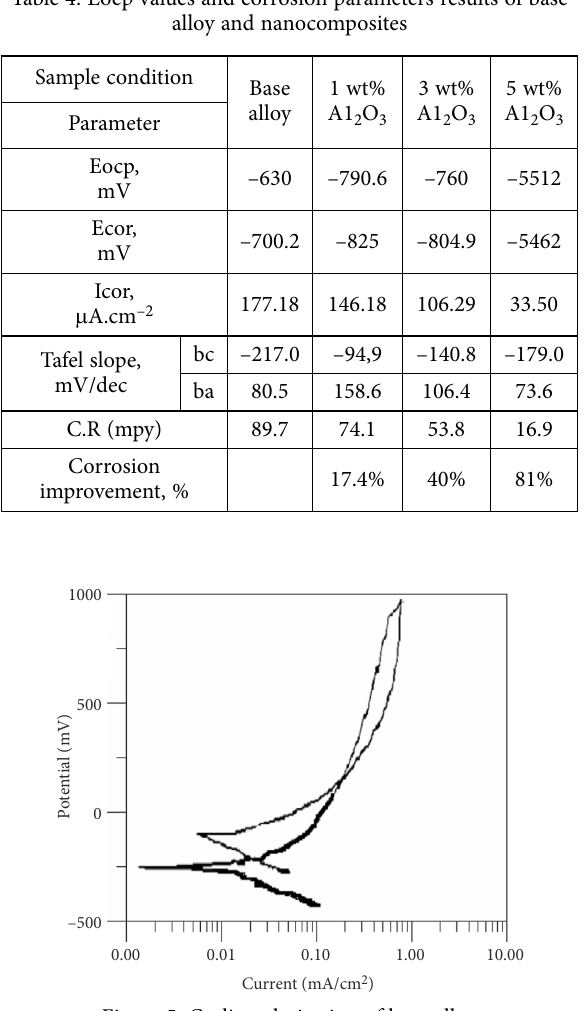
Figure 5. Cyclic polarization of base alloy